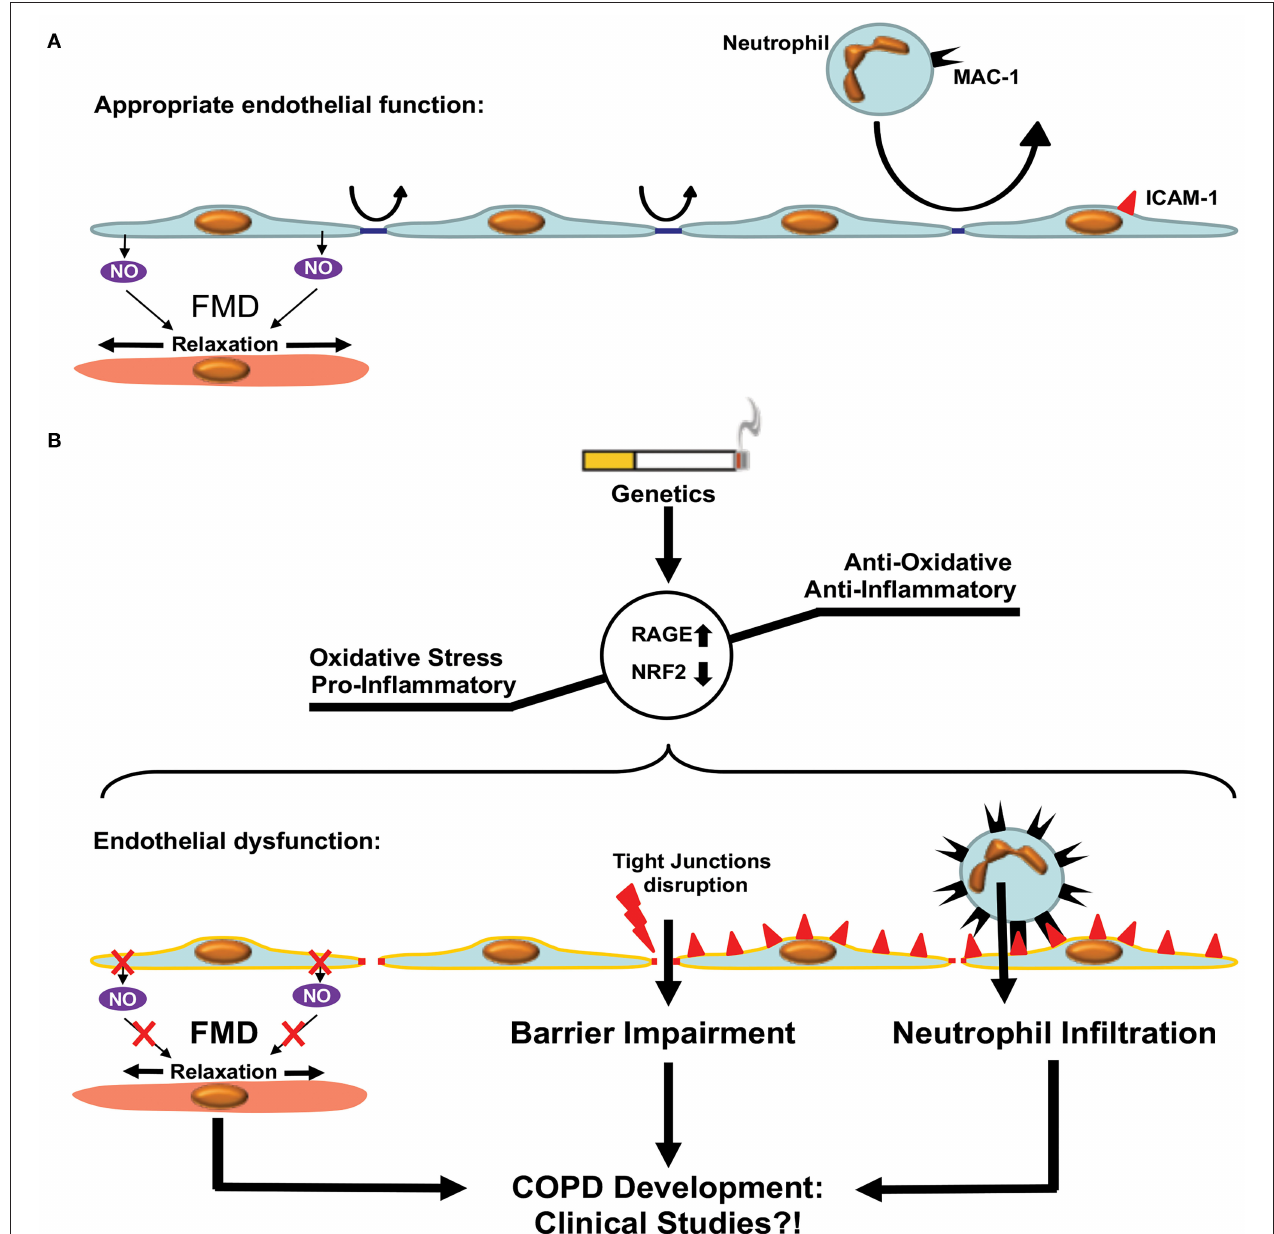
FIGURE 4 | Endothelial dysfunction in COPD. (A) Appropriate endothelial function under physiological conditions. The endothelium shows adequate flow mediated dilation (FMD) via relaxation of smooth muscle cells within the vascular media. Paracellular permeability is limited by intact tight junctions. Low adhesion molecule expression limits neutrophil extravasation in pulmonary tissue. (B) Development of COPD is accompanied by enhanced oxidative stress and a pro-inflammatory state resulting in a dysfunctional endothelium. Dysfunction is characterized by reduced FMD, impaired endothelial barrier function due to disruption of tight junctions and enhanced expression of adhesion molecules facilitating neutrophil extravasation. These processes promote COPD development via increased inflammation. Clinical studies are required in order to test the beneficial effects of therapies targeting ED in COPD patients.